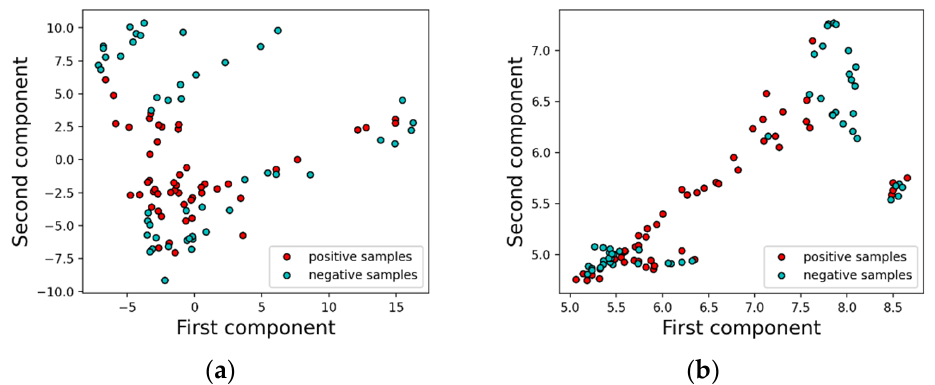
Figure 3. ( a ) 2D scatter plot of first and second principal components from PCA ( b ) 2D scatter plot of first and second components from UMAP.